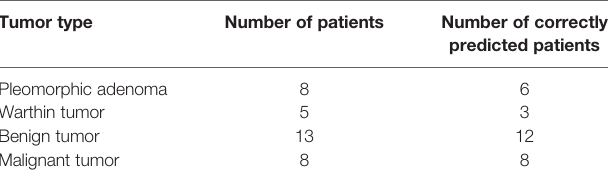
TABLE 5 | Accuracy of the decision-tree script in performing integrated prediction with the test set. Tumor